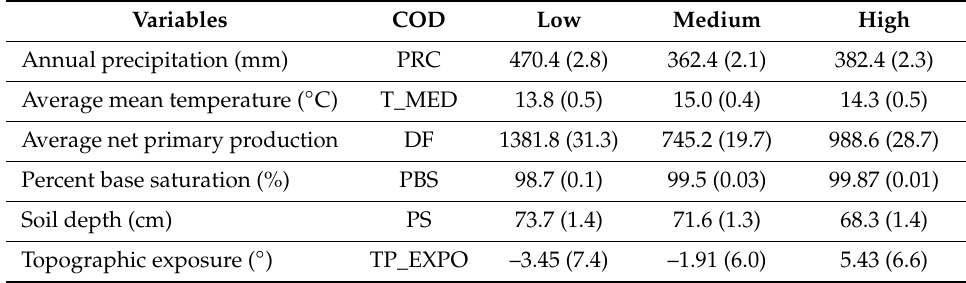
Figure 3. Boxplot of the selected predictor variables of ‘Candidatus Phytoplasma pini’ defoliation levels for the southeastern Andalusia Pinus halepensis forests. PS: Soil depth, PRC: Annual precipitation, TP_EXPO: Topographic exposure, PSB: Percent base saturation, T_MED: Average mean temperature, DF: Average net primary production. Outliers are included. Table 1. Environmental variables selected by the random forest model as predictors of defoliation classes of Pinus halepensis Mill. stands in south-eastern Spain (A) and Sierra de Baza Natural Park. “High” (defoliation-mortality covered 60–100% of the polygon), “Medium” (defoliation-mortality covered 26–59% of the polygon) and “Low” (defoliation covered < 25% of the polygon, with no evidence of mortality; Figure S2 Supplementary information).